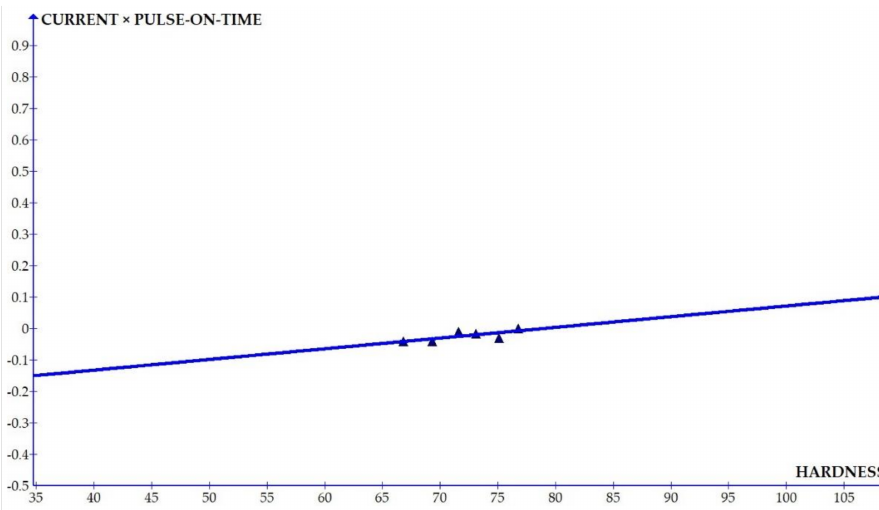
Figure 15. Coefficient of surface roughness: pulse on time × current vs. hardness.